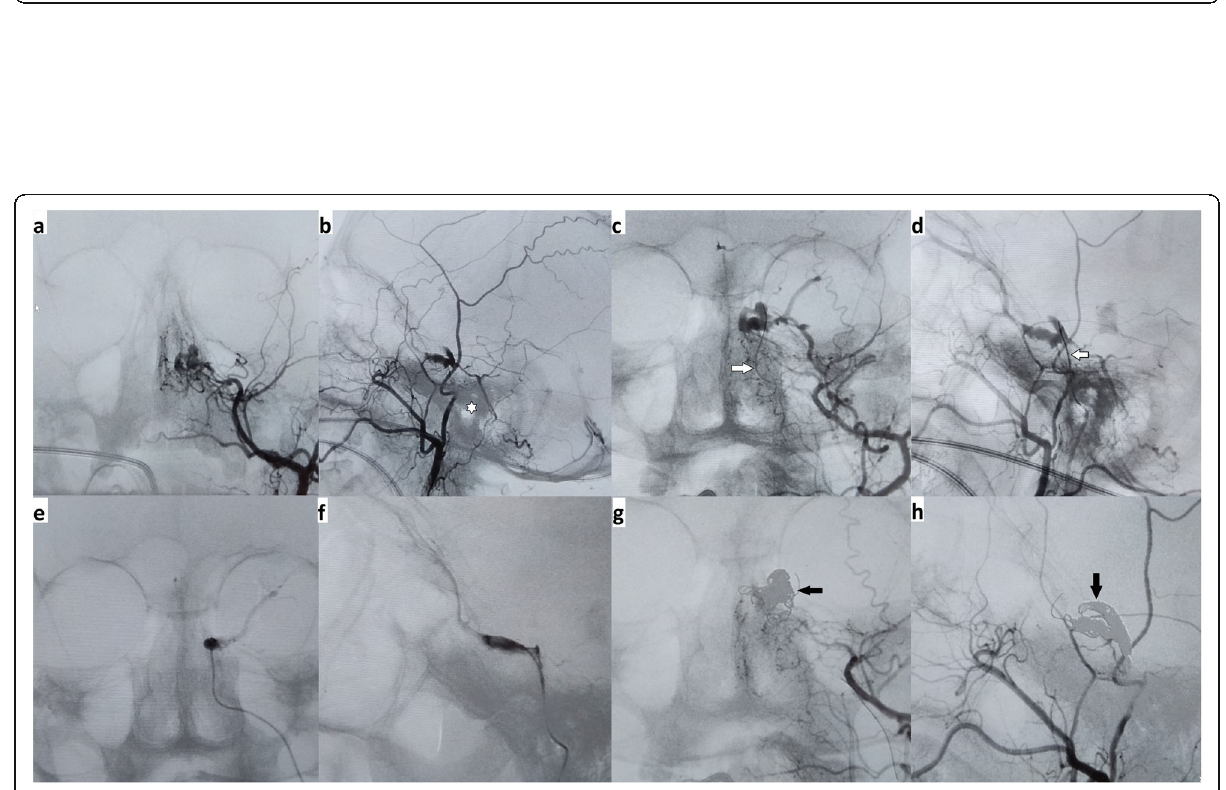
Fig. 5 Left ECA DSA in AP ( a ) and lateral ( b ) projections show type C indirect CCF with dilated SOV (white arrow) and facial vein (black arrow). DSA images in oblique ( c ) and lateral ( d ) projections show percutaneous puncture and selective cannulation of the left facial vein. DSA images in AP ( e ) and lateral ( f ) projections show the microcatheter tip in left cavernous sinus and occluded left IPS (arrow in f ). Post coiling DSA in AP ( g ) and lateral ( h ) projections show complete embolization of the fistula with coil mass in the left cavernous sinus and adjacent segment of